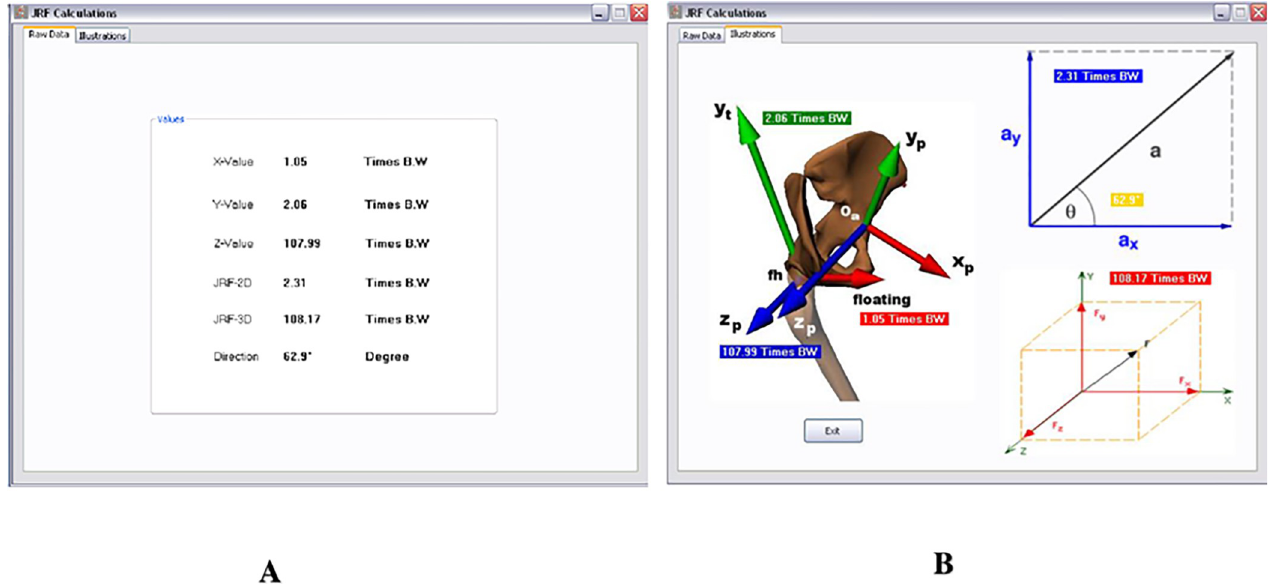
Fig 7. JRF calculation. (A) The first window indicates Raw Data. (B) The second window is an illustration of the raw data indicated in window A.